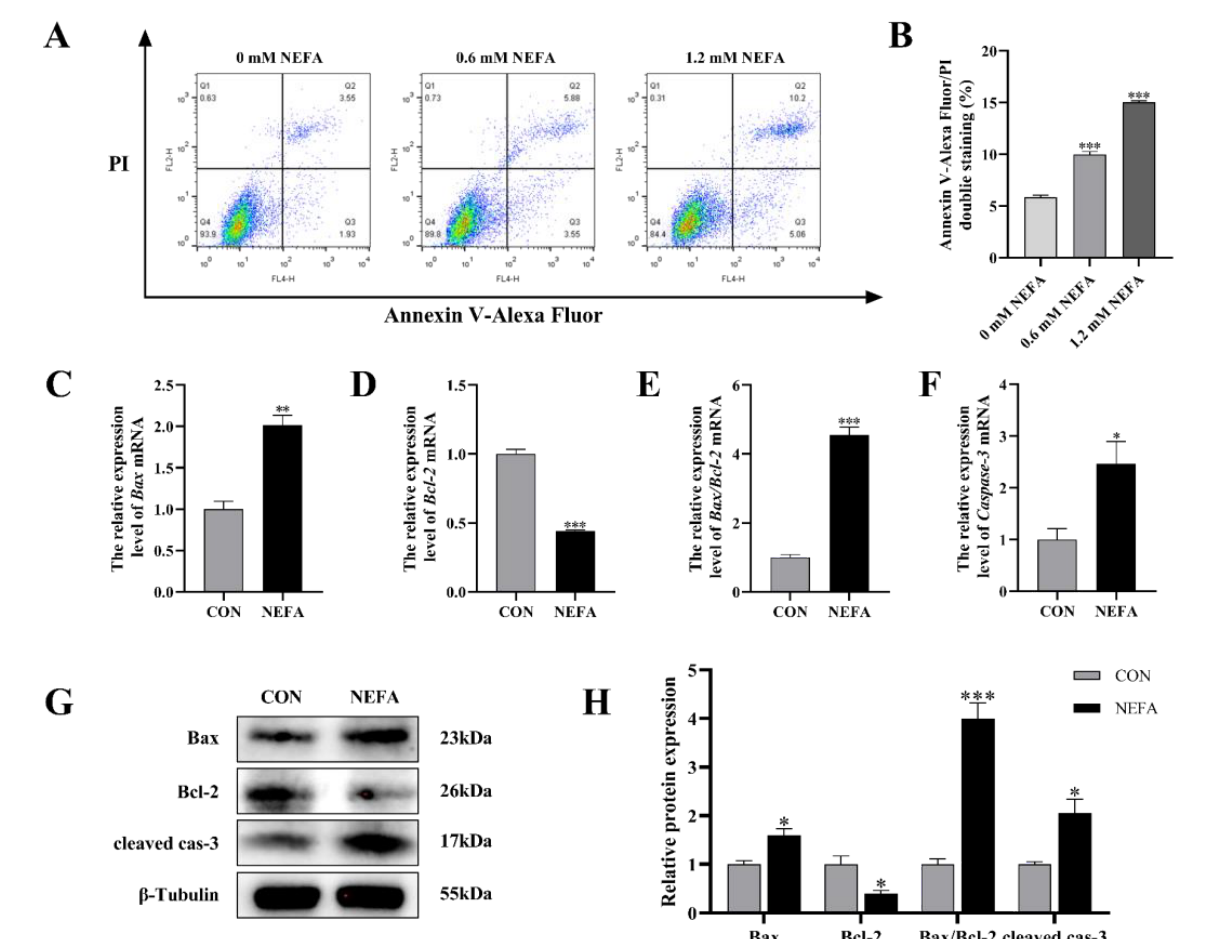
Figure 3. NEFA − induced apoptosis in BGCs. BGCs were treated with or without 1.2 mM NEFA for 24 h. ( A , B ) The apoptosis of BGCs which were treated with 0, 0.6, and 1.2 mM NEFA was determined by flow cytometry and analyzed using FlowJo. ( C – F ) The apoptosis − related mRNA levels of Bax, Bcl − 2, and Caspase − 3 were determined using qRT − PCR. ( G , H ) The apoptosis − related proteins Bax, Bcl − 2, and Caspase − 3 were analyzed by Western blot. The quantification of the relative protein levels (performed using Image J) is shown under the band (protein/ β − Tubulin). This experiment was repeated 3 times, and data are expressed as mean ± standard errors of the mean (SEM), * p < 0.05; ** p < 0.01; *** p < 0.001; ns, not significant.